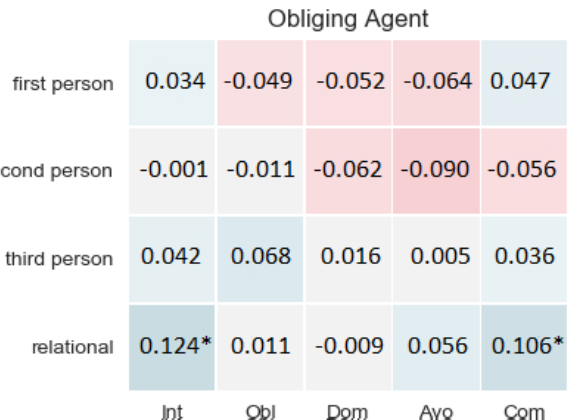
Figure 9. Correlation coefficients between first person, third person and relational pronouns used during the interaction with the Obliging virtual agent and the ROCI-II scores. (*) Significant values ( p < 0.05) are marked with